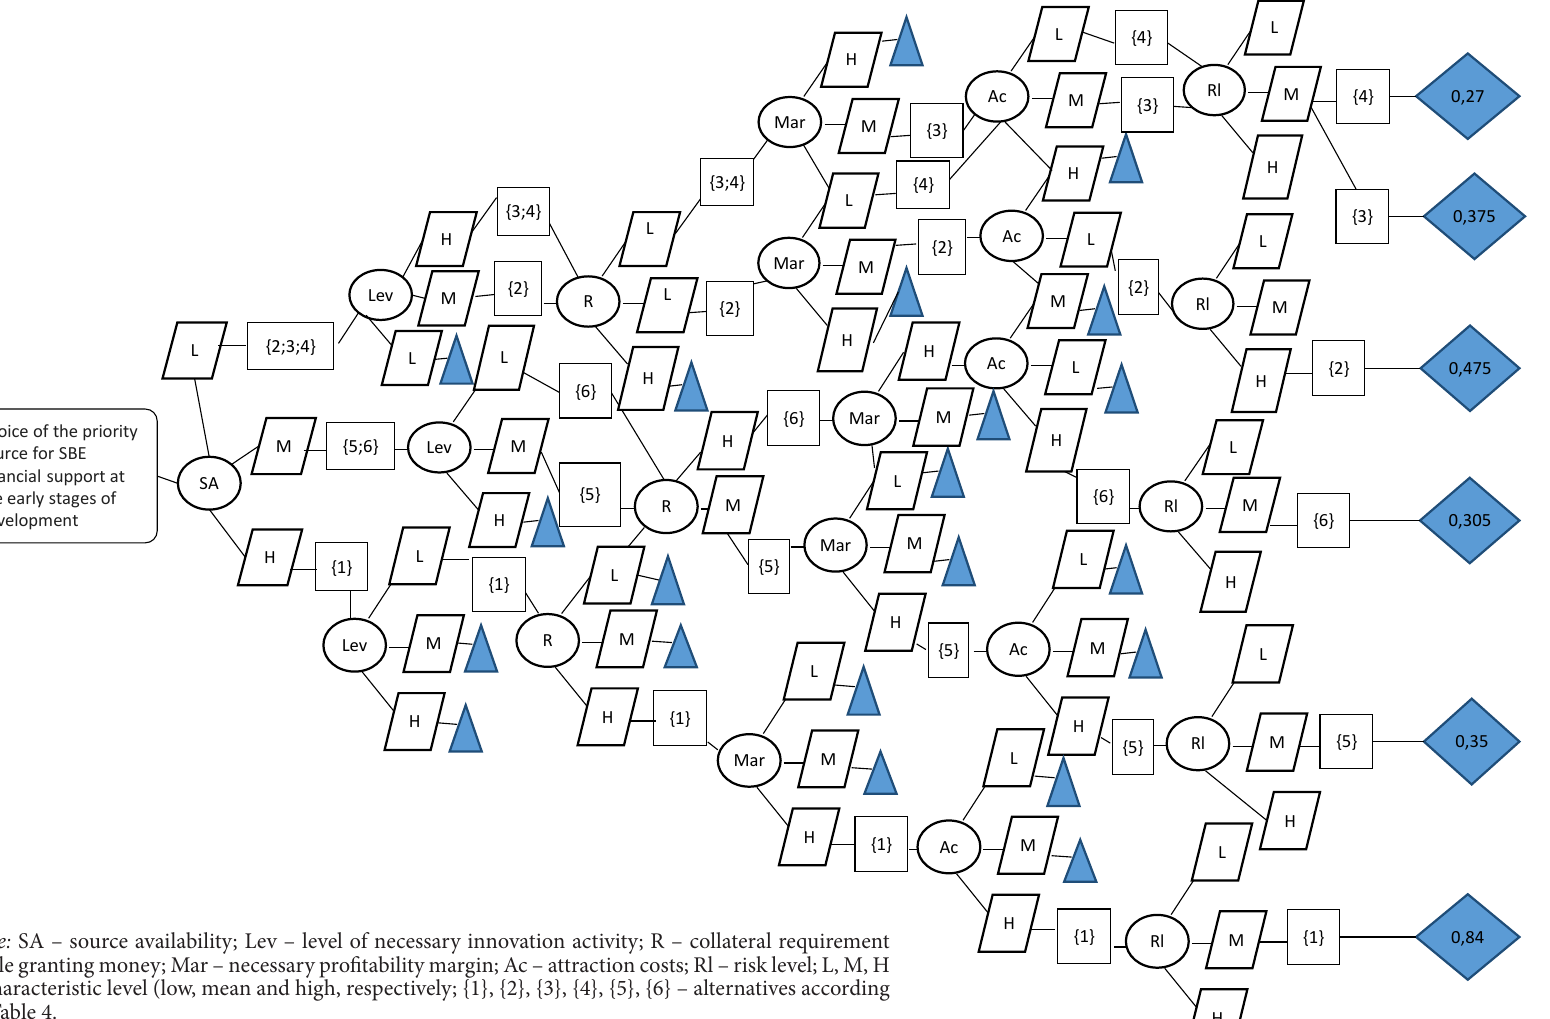
Figure 8. Decision tree: choice of the priority source to form SBE financial support at the early stages of development